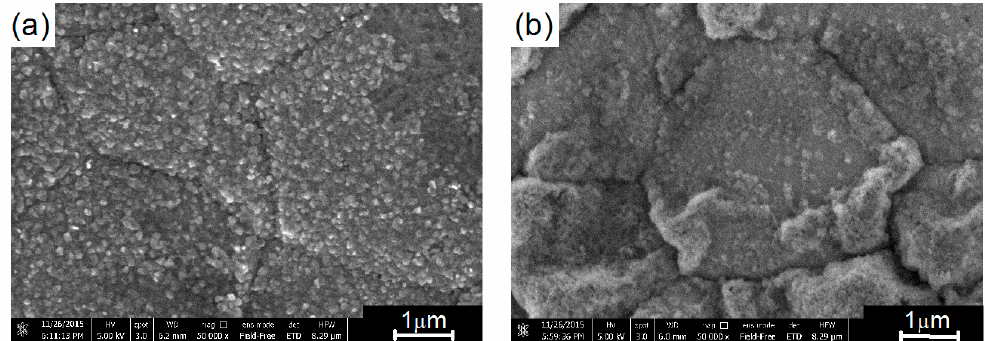
Figure 4. Typical SEM images of the film of magnesium nanoparticles obtained after 5 h of electrochemical deposition on Ni and subsequent hydrogenation at ( a ) 200 °C and ( b ) 300 °C and 3 MPa hydrogen pressure.